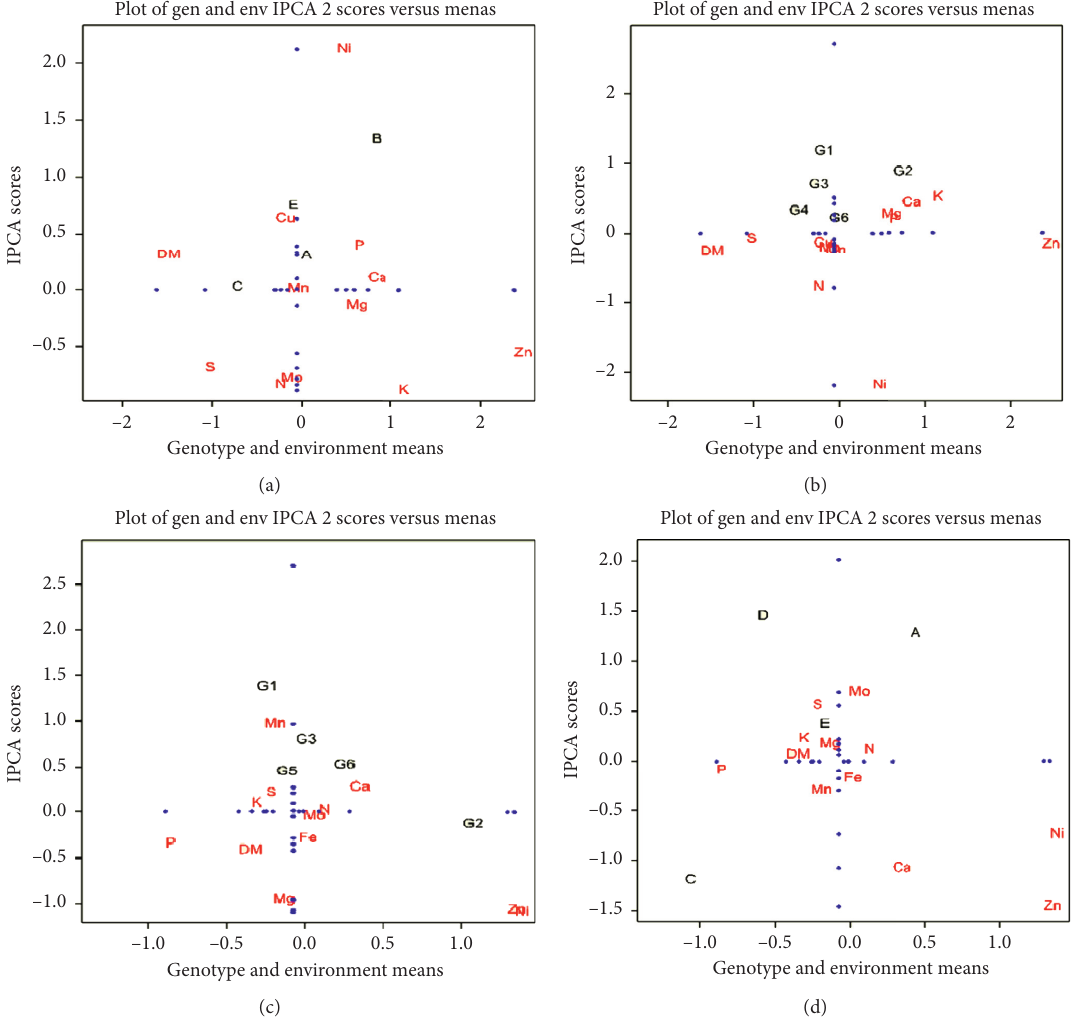
Figure 5: AMMI Biplot on leaves and stalk. (a) AMMI Biplot interaction sampling times in nutrient on stalk, (b) AMMI Biplot interaction NPK in nutrient on stalk, (c) AMMI Biplot interaction sampling times in nutrient on leaves, (d) AMMI Biplot interaction NPK in nutrient on leaves. G1-G6 (treatments N0 –N5), A-E (sampling times). Nitrogen (N), potassium (K), phosphorus (P), magnesium (Mg), calcium (Ca), sulphur (S), zinc (Zn), iron (Fe), copper (Cu), manganese (Mn), nickel (Ni), and molybdenum (Mo). Nutrient composition of grain and